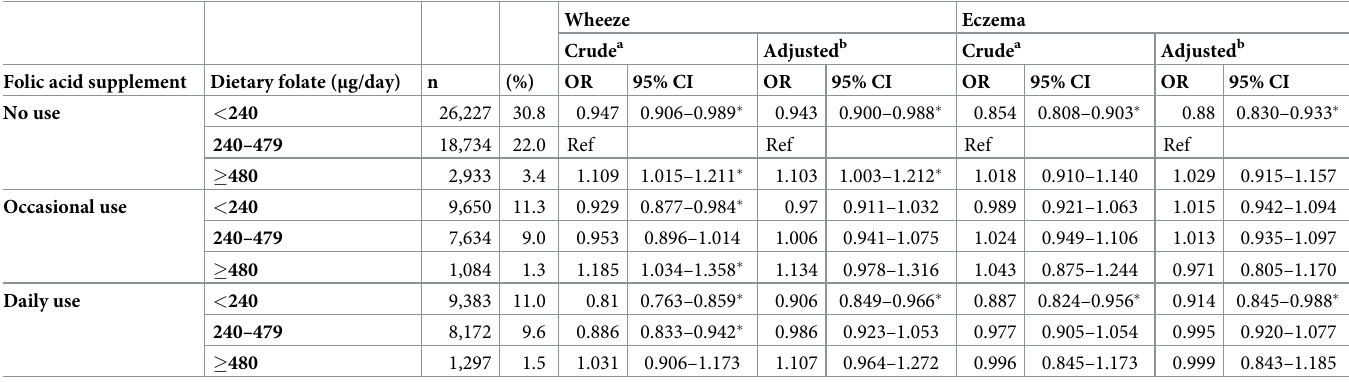
Table 4. Folic acid (supplement and diet) and